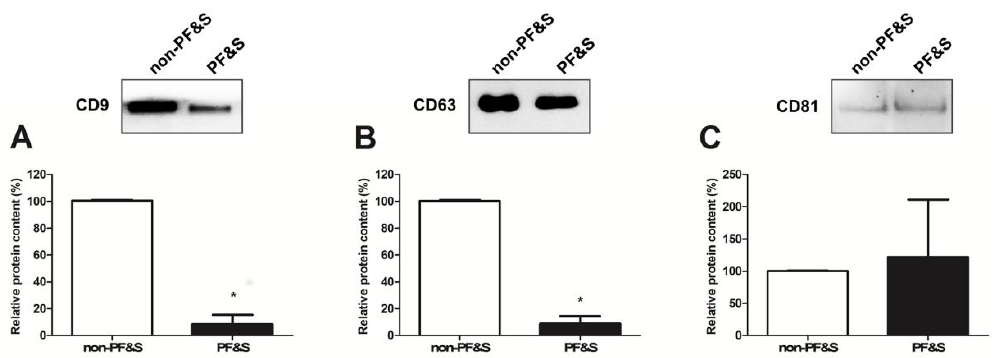
Figure 3. Protein expression of ( A ) CD9, ( B ) CD63, and ( C ) CD81 in purified small extracellular vesicles (sEVs) from non-physically frail non-sarcopenic (non-PF&S) controls (n = 10) and participants with physical frailty and sarcopenia (PF&S; n = 11). Data were normalized for the amount of sEV total proteins and are shown as percentage of the control group set at 100%. Bars represent mean values ( ± standard error of the mean). * p < 0.0001 versus non-PF&S. As for sEV cargo characterization, protein levels of adenosine triphosphate 5A (ATP5A; complex